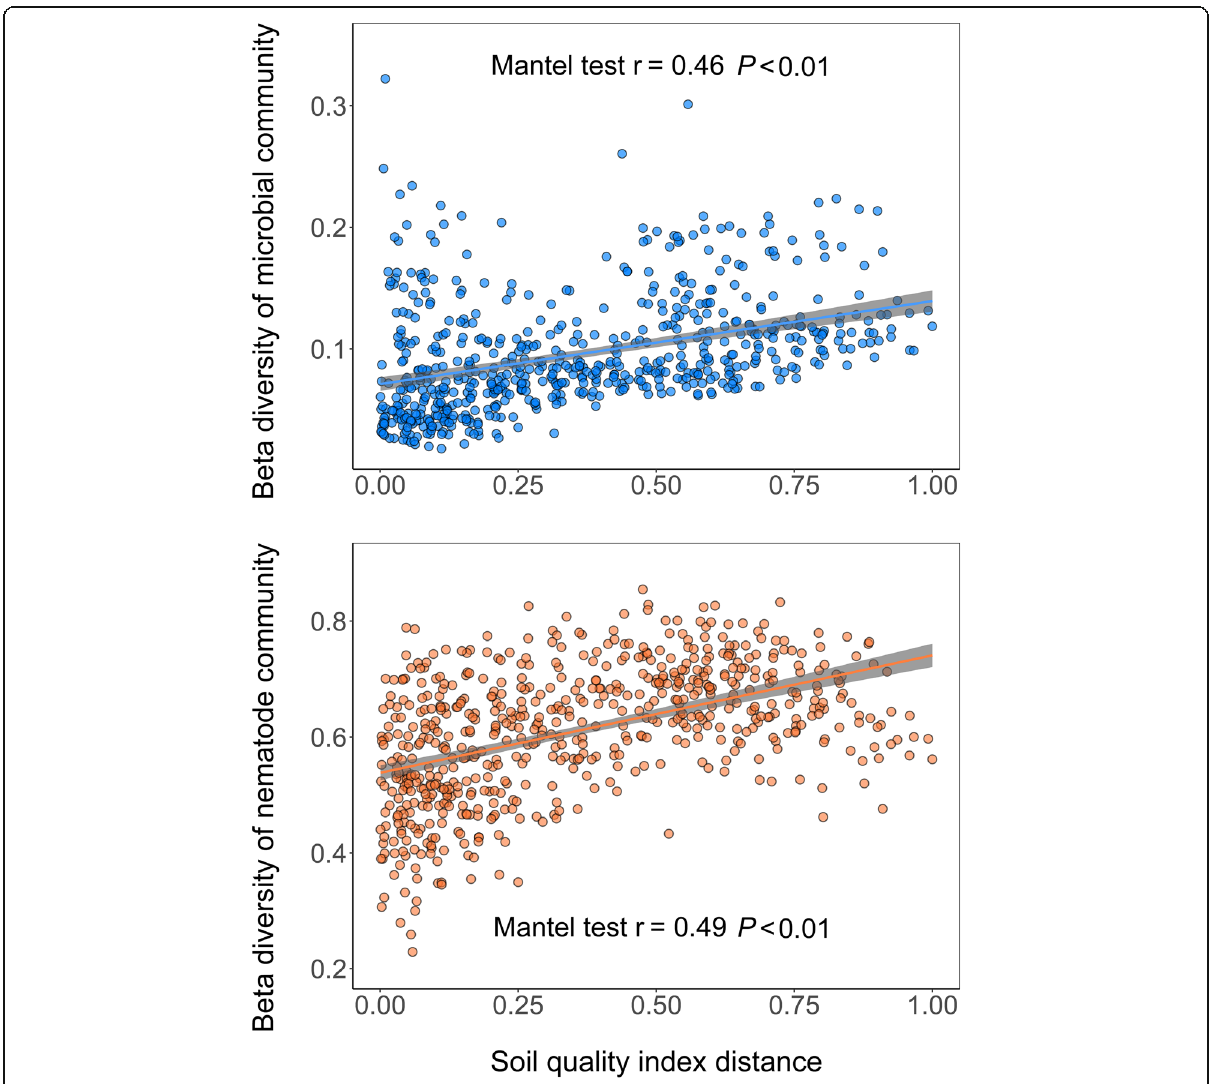
Fig. 6 Correlation between the beta diversity of soil microbial/nematode communities (Bray-Curtis distance) and the soil quality index distance (Euclidean distance) along the grassland degradation gradient (based on n = 36 soil